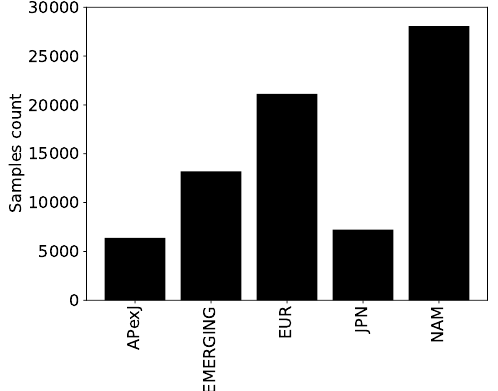
Figure 1. Number of samples in each Fama–French region in the Refinitiv ESG dataset.